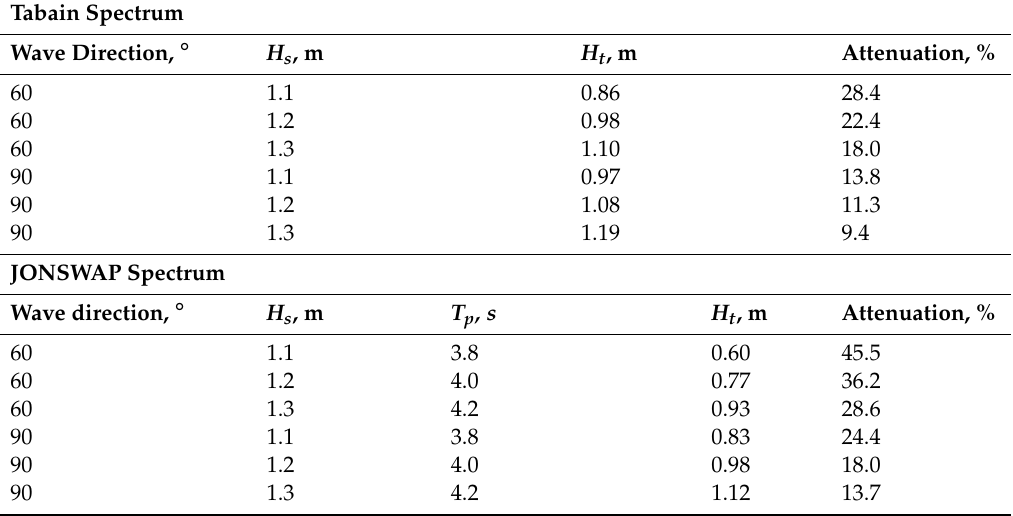
Table 3. Evaluated values of the